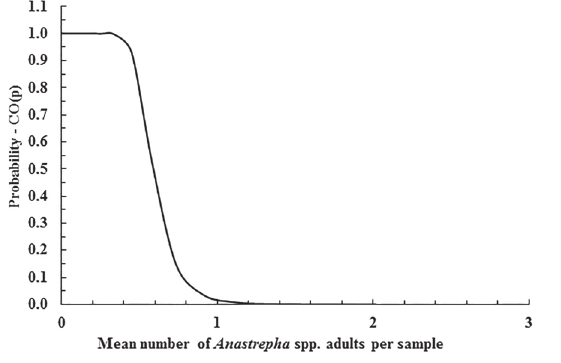
Figure 1 - Decision lines of the sequential sampling plan for the number of Anastrepha spp. defined by thetheoretical Negative Binomial distribution (Bn) in three orchards of ‘Novo Milênio’ guava cultivar, Ivinhema, State of Mato Grosso do Sul, Brazil (August 2013 to January 2014). Sequential Probability Ratio Test.